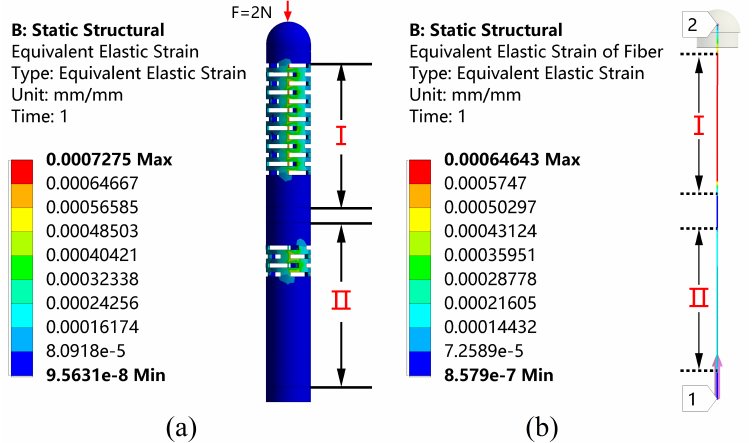
Figure 2. Strain distribution on ( a ) the overall structure and ( b ) the fiber under the axial force F stimulation.